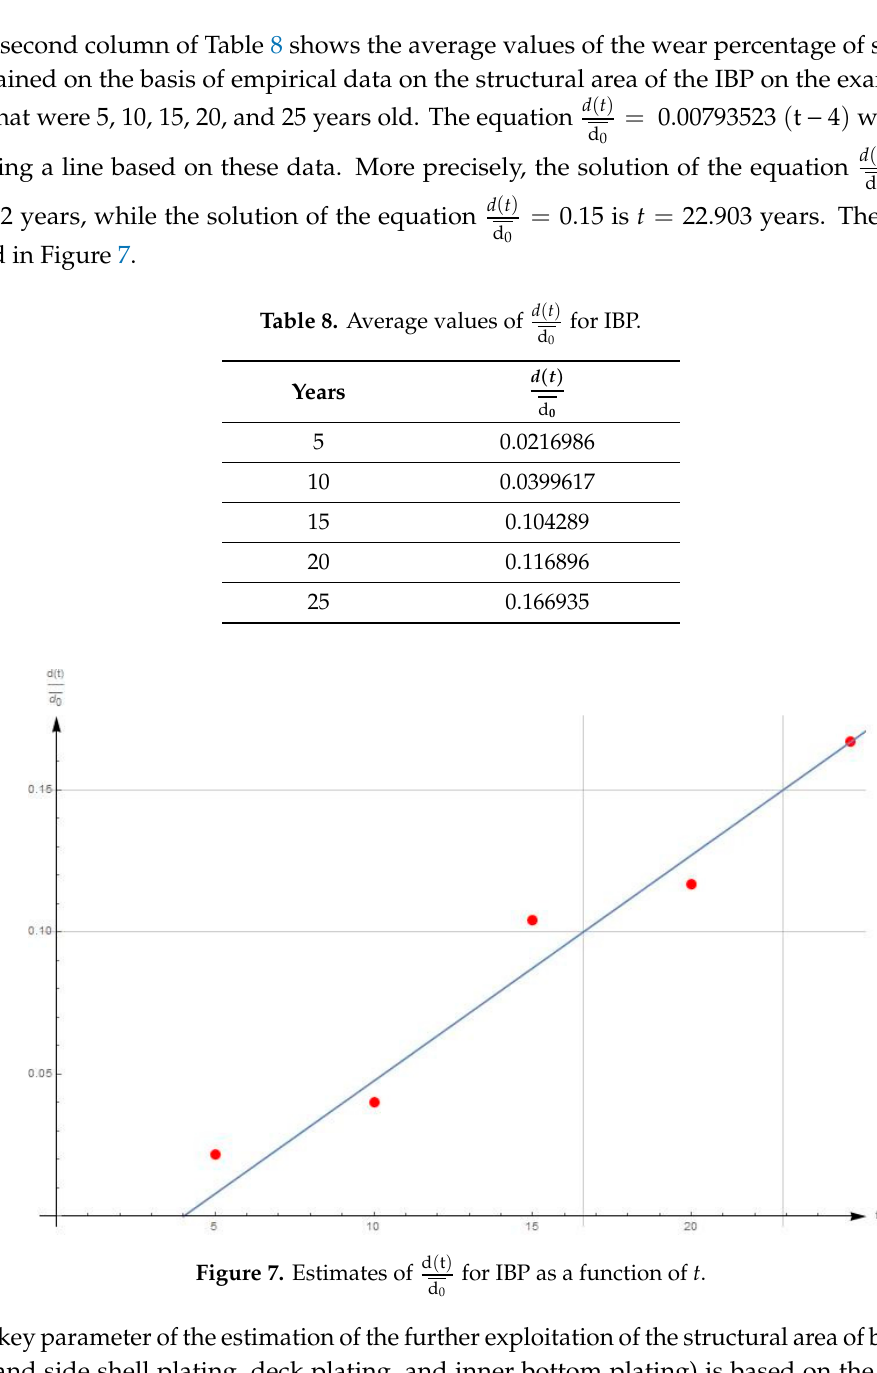
Figure 7. Estimates of d ( t ) for IBP as a function of t (cid:2914) (cid:3116) d 0